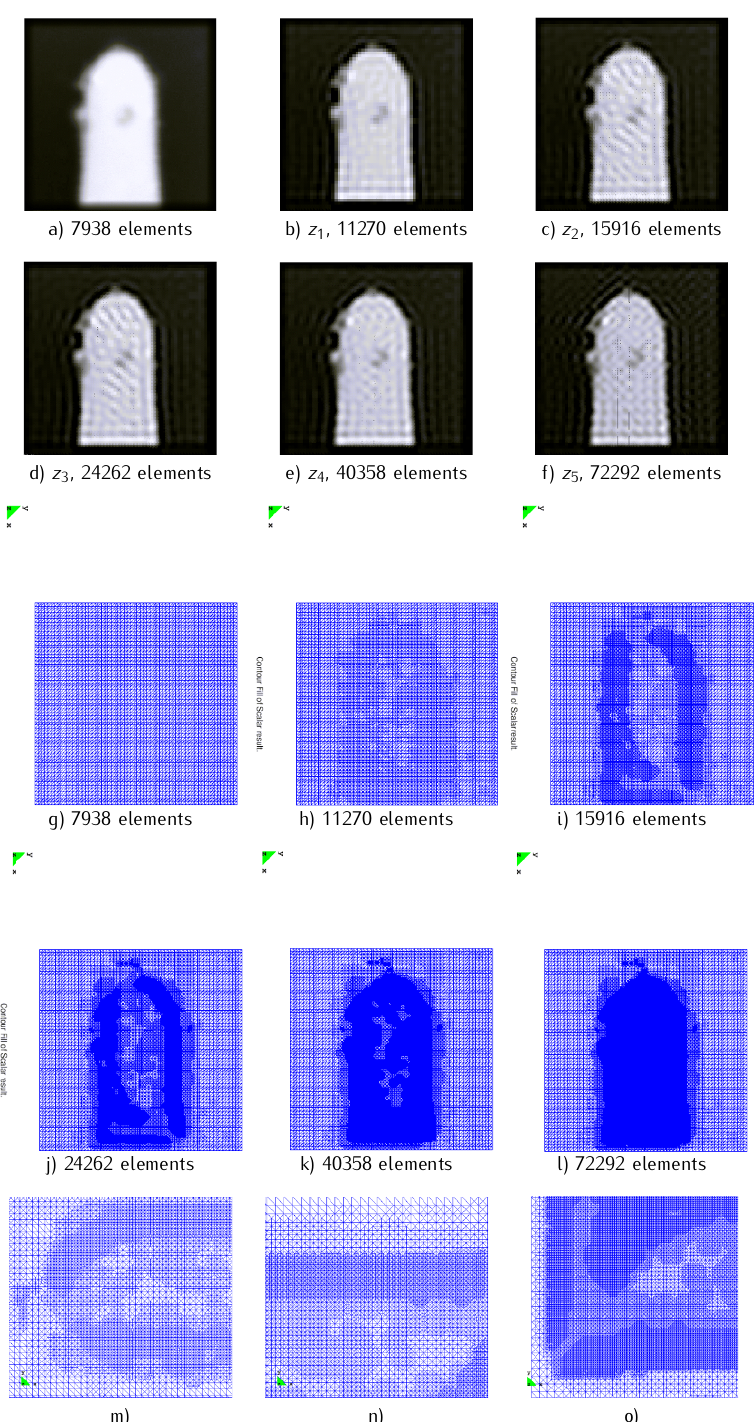
Figure 4. Test 3. Reconstruction of the function z ( x 1 ,x 2 ) from the experimental backscattering data obtained by the microtomograph [18, 23]. In a) we present the real measured signal u ( ξ,η ) on the part of the planar microscheme Ω obtained by the microtomograph at the depth 0.9 µ m. In b)–f) we show results of the reconstruction of the function z ( x 1 ,x 2 ) on different adaptively refined meshes using the algorithm of Section 8. Adaptively refined meshes corresponding to images b)–f) are presented in h)–l). Enlarged parts of refined meshes in j), k), l) are presented in m), n), o)